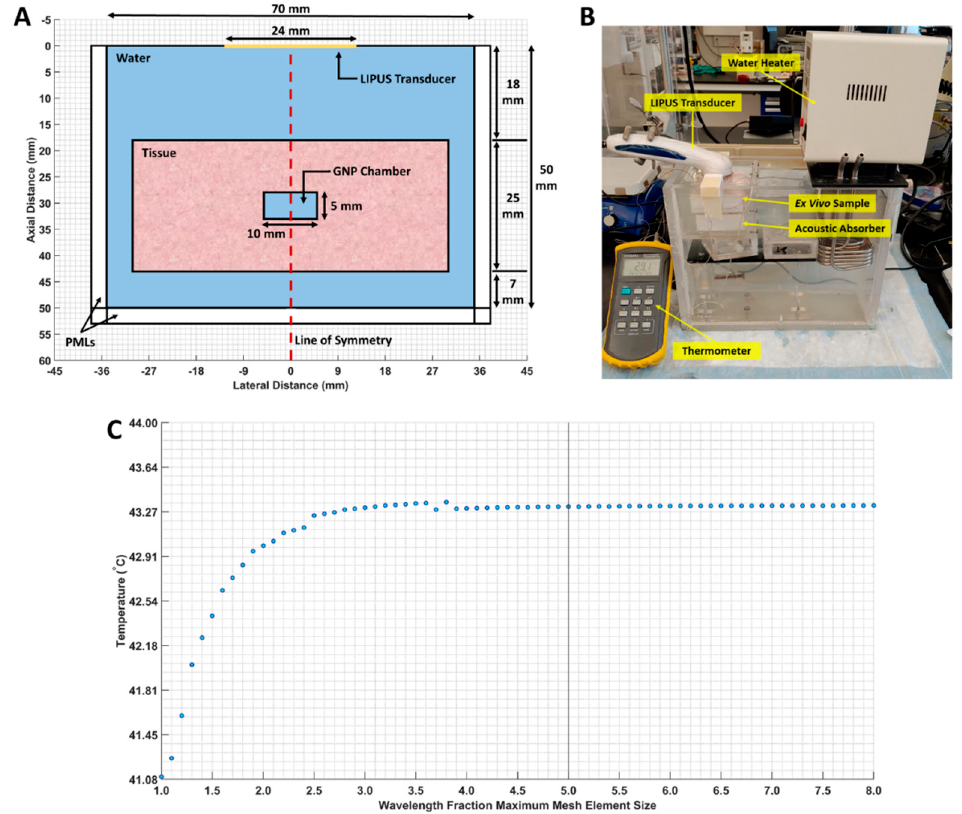
Figure 1. ( A ) The 2D axisymmetric geometry of the computational domain. The water, tissue, GNP chamber (water-filled chamber), and line of symmetry are indicated; ( B ) our ex vivo experimental setup; ( C ) maximum mesh size, versus the average GNP chamber temperature. The selected mesh size is marked by a vertical line.